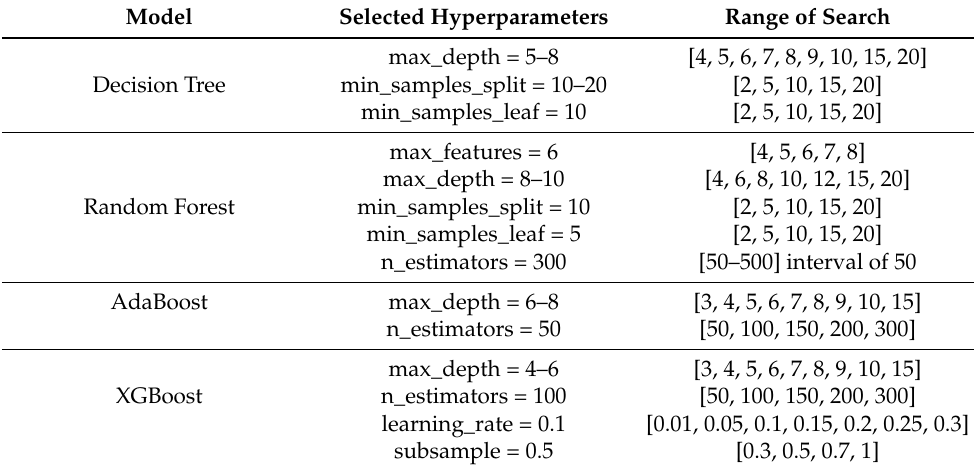
Table 2. Hyperparameters of developed machine learning models.